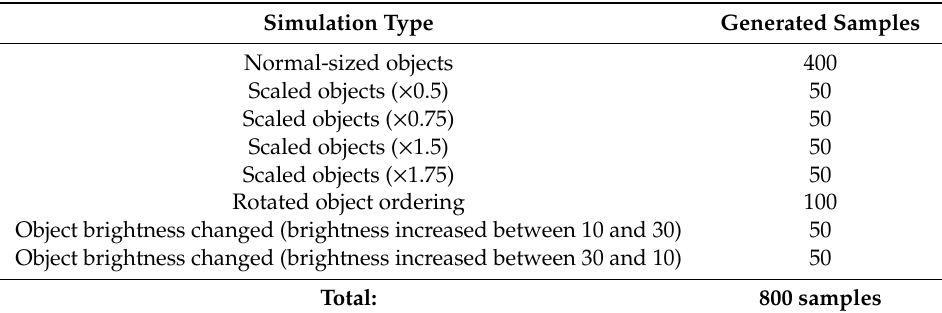
Table 3. Simulated training sample description.